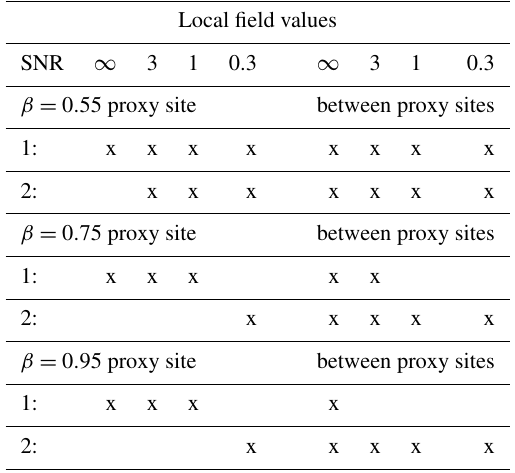
Table 2. Hypothesis testing results for local reconstructed data compared to Monte Carlo ensembles of fGn and AR(1) processes. The “x” mark in the table indicates that the null hypothesis cannot be rejected. Null hypotheses are 1: the reconstruction is consistent with the fGn structure in the target data for all frequencies; 2: the reconstruction is consistent with the AR(1) assumption from BAR- CAST for all frequencies.